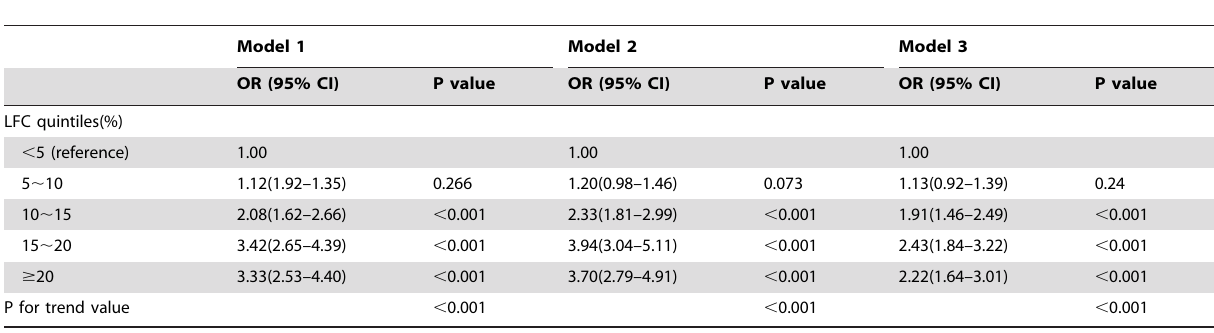
Table 3. Odds ratios of impaired glucose profiles according to LFC